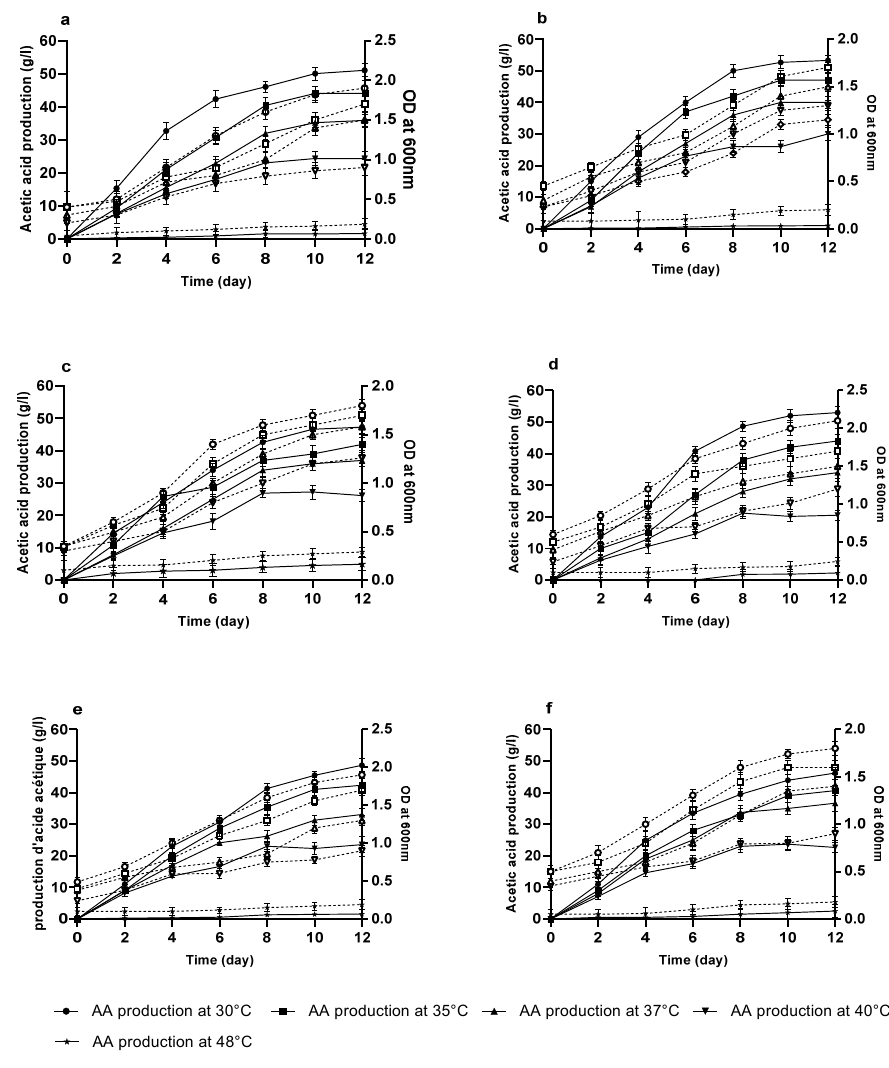
Figure 7. Kinetics of acetic acid production and bacterial growth of the six strains studied: FAGD1 ( a ). FAGD10 ( b ). FAGD18 ( c ). GCM2 ( d ). GCM4 ( e ). GCM15 ( f ).